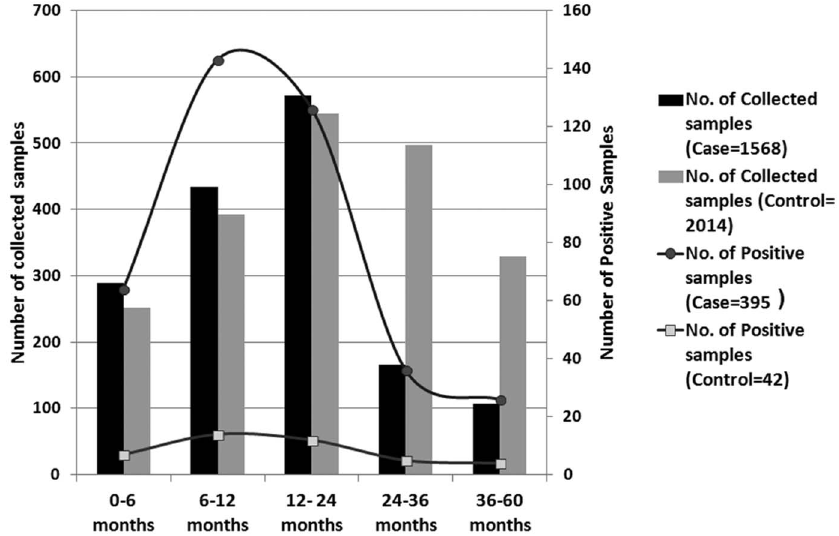
Figure 1. Age distribution. Age –wise distribution of rotavirus-positive Case and Control children (0–5 years) against total collected samples during January 2008 through December 2010. doi:10.1371/journal.pone.0112970.g001 PLOS ONE |